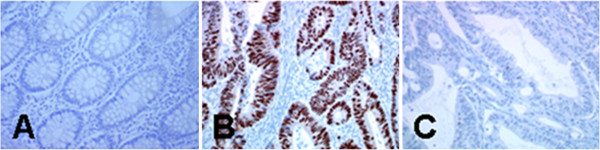
Immunohistochemical staining pattern of p53. (A) Normal adjacent tissue (× 20); (B) high positive staining detecting in the nucleus of the tumour cells (× 10); (C) negative control without the primary antibody (× 20).